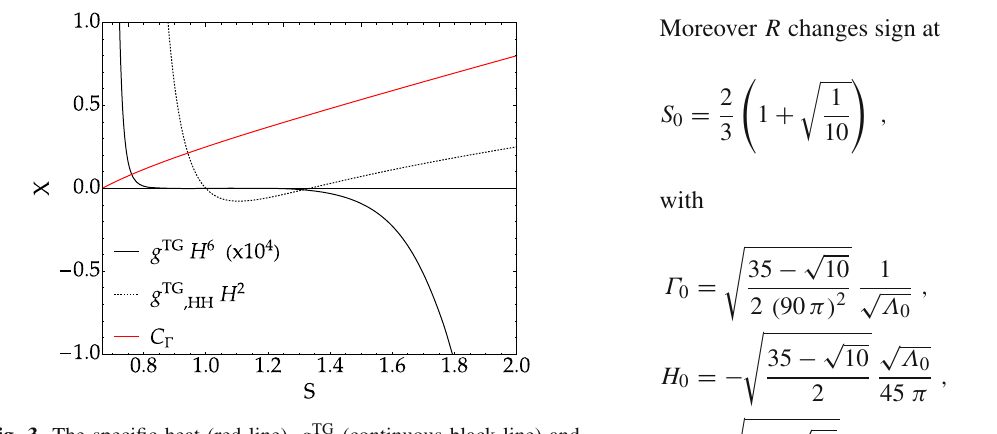
Fig. 3 The specific heat (red line), g TG (continuous black line) and g TG , (dotted line) for Schwarzschild BH HH